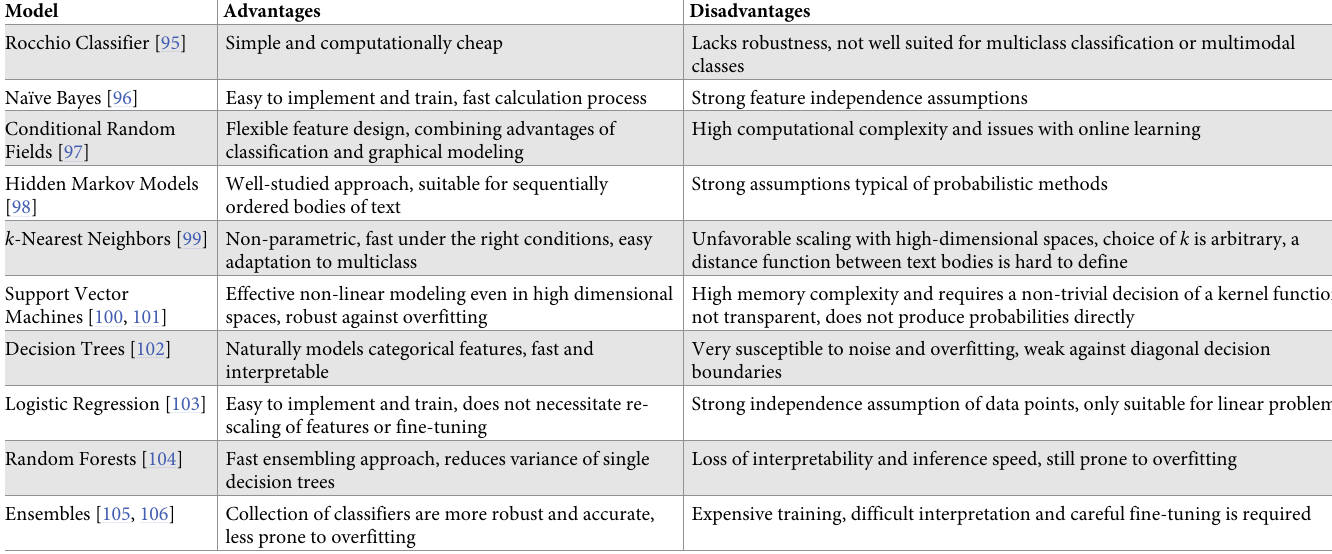
Table 3. Traditional classification